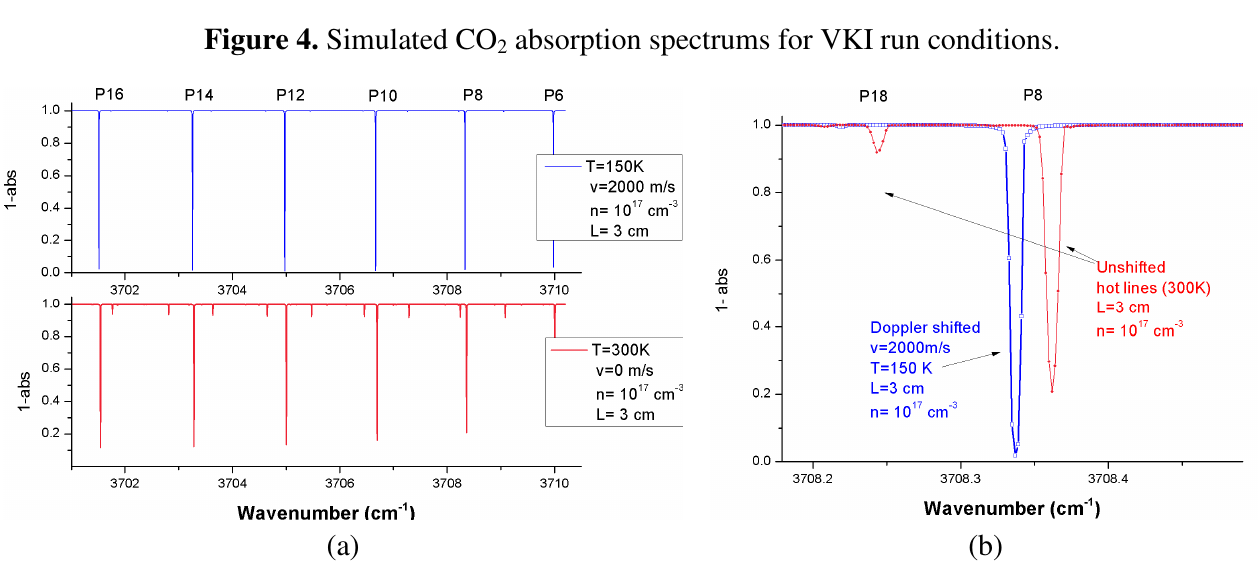
Figure 4. Simulated CO